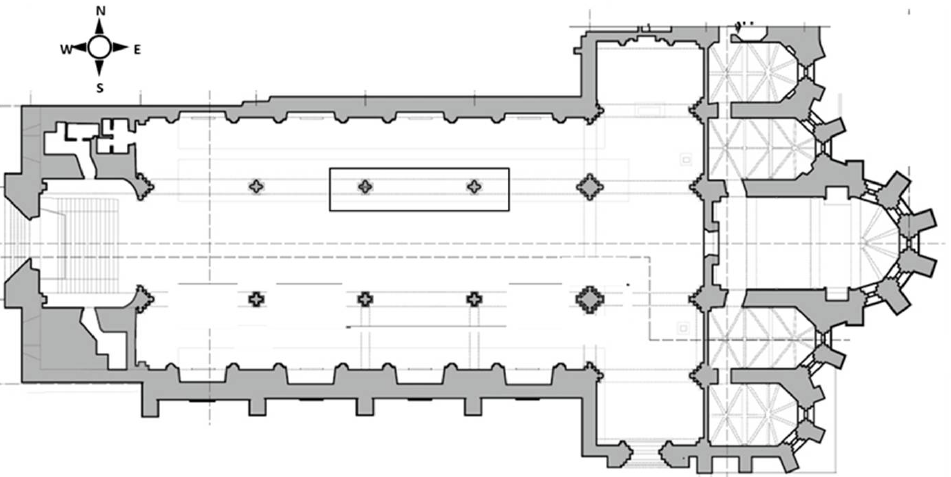
Figure 19. Latin cross plan of Convent do Carmo, highlighting the masonry columns that were inspected with a black rectangle.